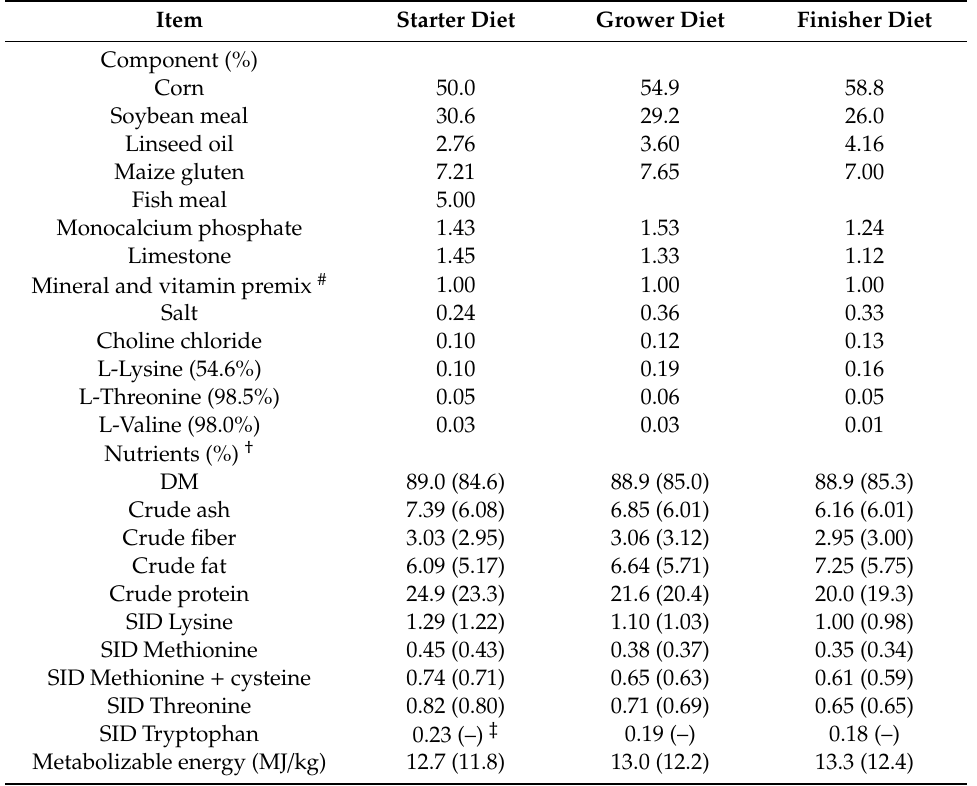
Table 1. Compositions of the basal